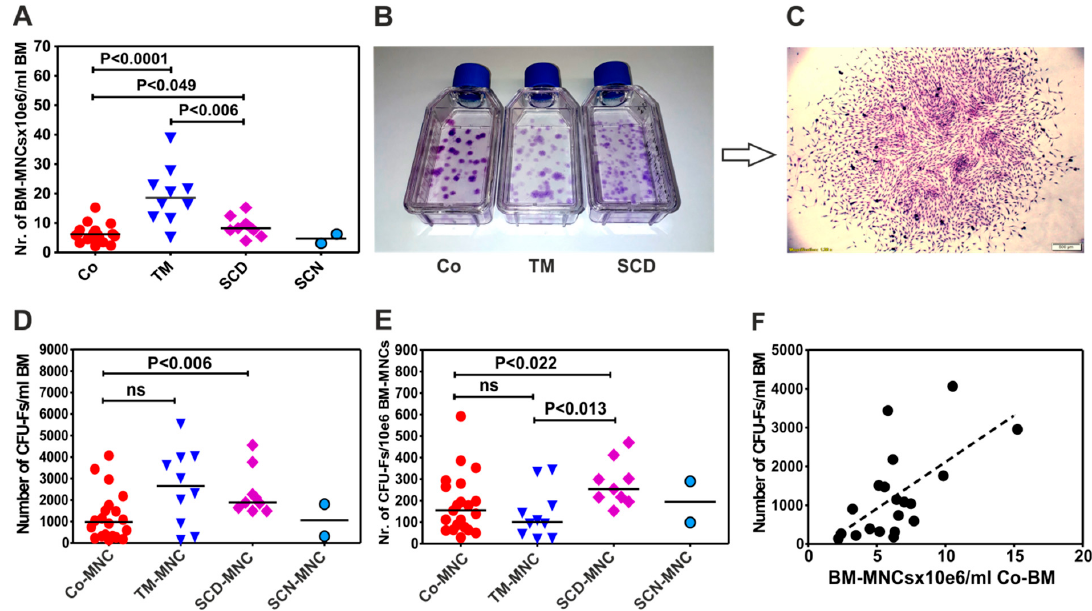
Figure 1. Cellularity and clonogenic potential of bone marrow mononuclear cells in patients with non-malignant hematological diseases (NMHD) ( A ) Cellularity of the bone marrow in patients with NMHD. ( B ) Morphology of colony-forming units-fibroblast CFU-Fs cultured in tissue culture flasks ( C ) A typical CFU-F, consisting of fibroblast-like cells. ( D ) Number of progenitor cells for mesenchymal stromal cells (MSCs) per milliliter BM aspirate of healthy donors and patients with NMHD. ( E ) Number of progenitor cells for MSCs per 1 × 10 6 bone marrow mononuclear cells